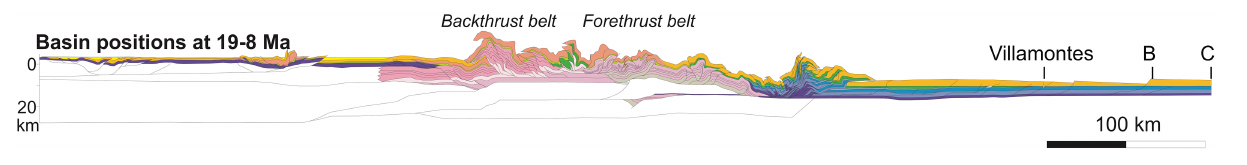
and Interandean Zone, and the cross-sectional area of basin fill in the Chaco foreland. Eroded area was determined from the portions of the balanced cross section of Anderson et